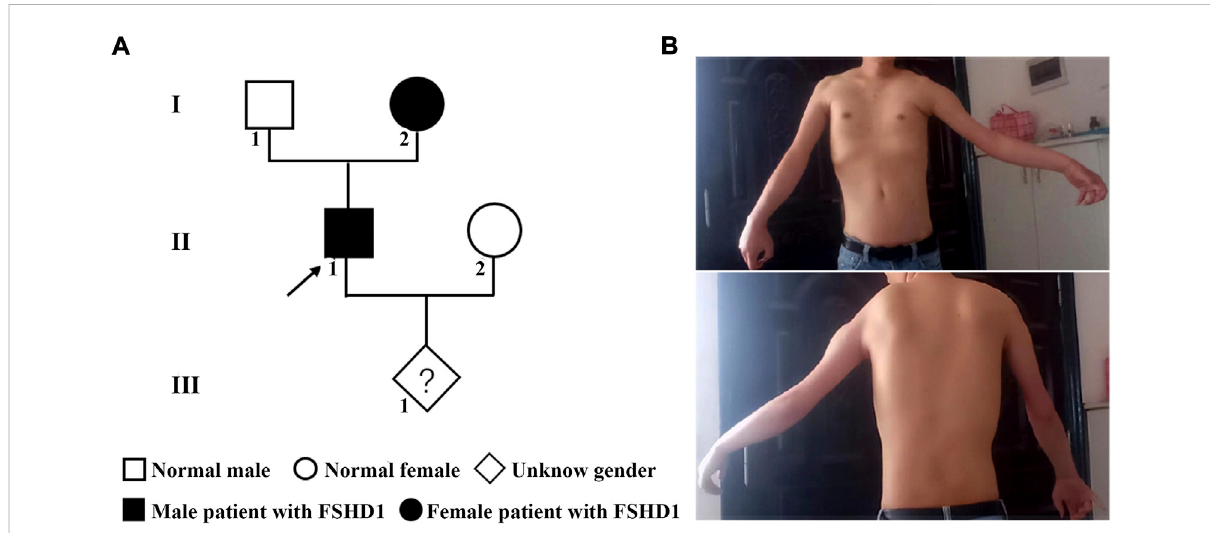
FIGURE 1 The pedigree and phenotype of the family with FSHD1. (A) The genetic map of the FSHD1 family. (B) Typical upper body pro fi le of the patient with facioscapulohumeral muscular dystrophy. The proband showed asymmetric limitation of shoulder abduction, pectoral muscle atrophy and asymmetric scapular winging.